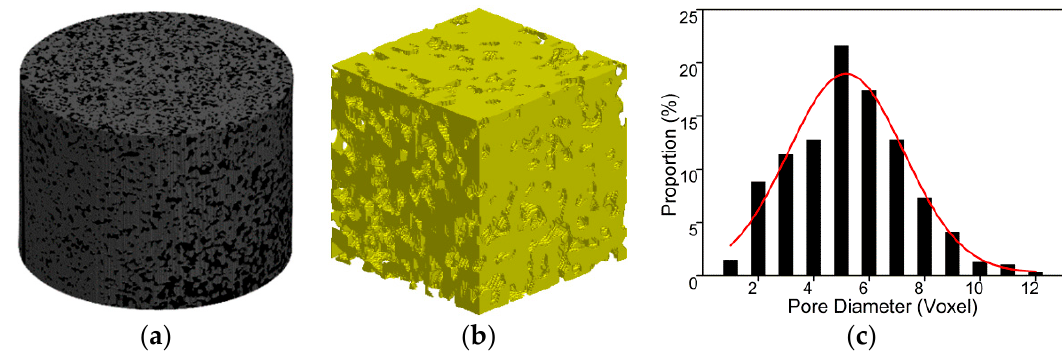
Figure 1. ( a ) 3D image of soil, acquired using X-ray tomography, with the pores in black and solid in grey; ( b ) the cube (sample 1) trimmed from the soil; ( c ) pore-size distribution.